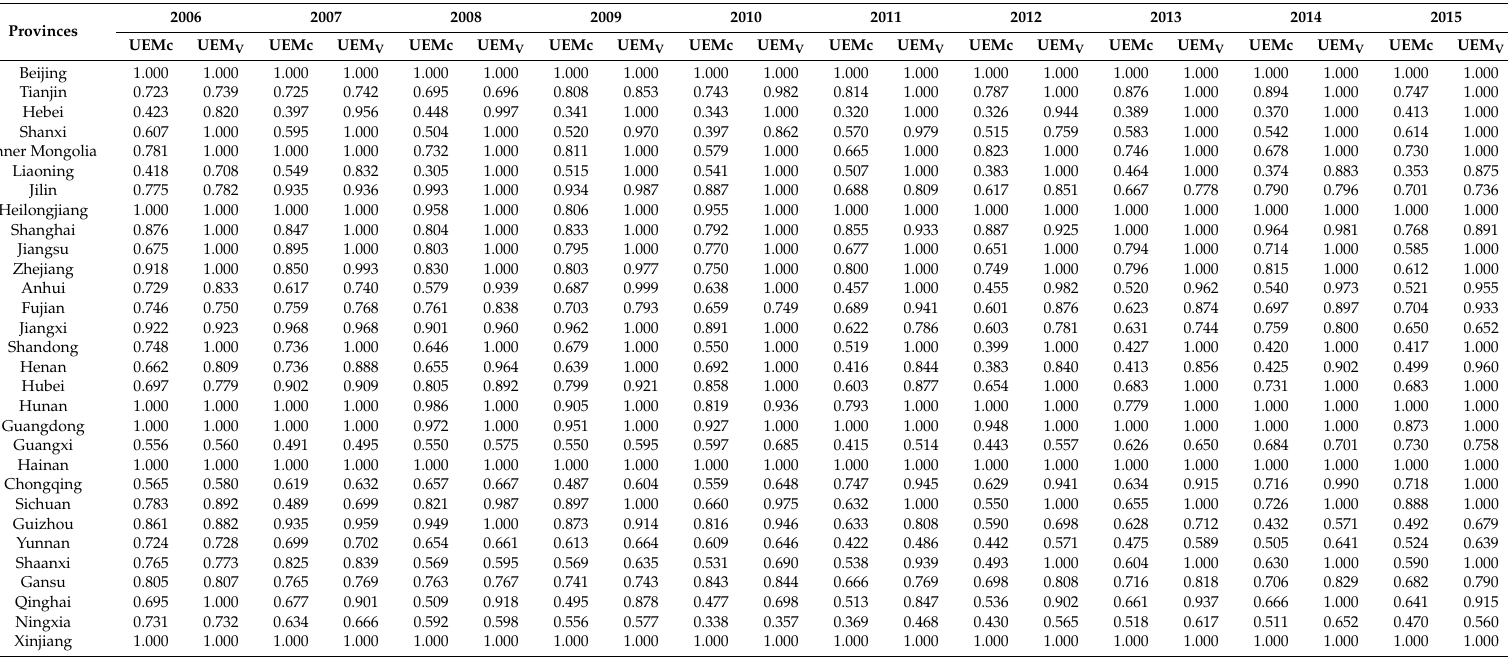
Table 3. Unified environmental e ffi ciency under managerial disposability from 2006 to 2015.